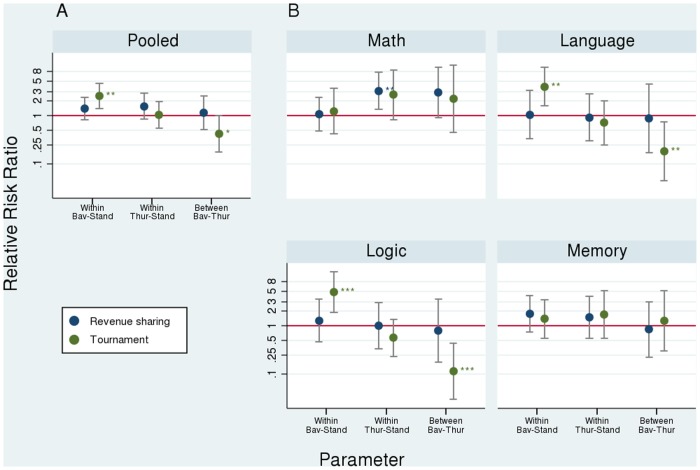
Predicted margins of Bavarian accent conditional on age and gender controls with the 90% confidence interval.Standard errors are clustered by subject. This graph shows the predicted margins of the probability of choosing tournament from a multinomial logit model (Table 3) using age and gender as additional control variables. EPs do not chose the tournament more often when perceiving the Thuringian accent, but tournament take up increases strongly when perceiving the Bavarian accent.